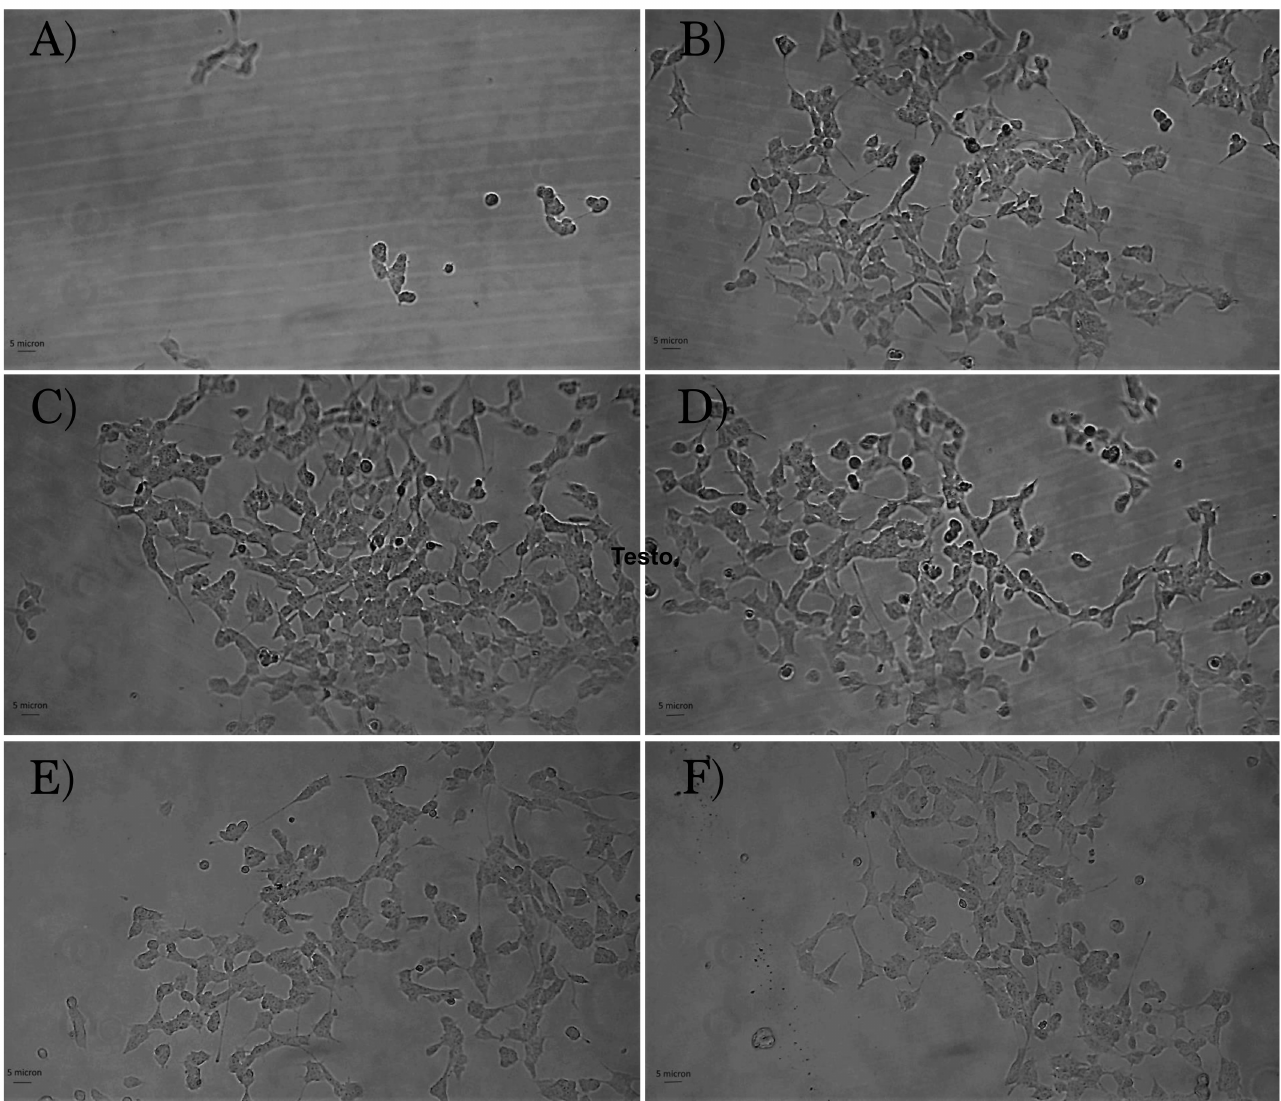
Figure 12. Optical microscope images of NIH3T3 mouse fibroblasts after 24 h of contact with: ( A ) positive control; ( B ) negative control (LDPE); ( C ) HA(270)-FA-HEG-CL-10 ; ( D ) HA(270)-FA-HEG- CL-20 ; ( E ) HA(270)-FA-HEG-CL-40 ; ( F ) HA(8.7)-FA-HEG-CL - 20 . Databar 5 µ m. Magnification: 20 ×